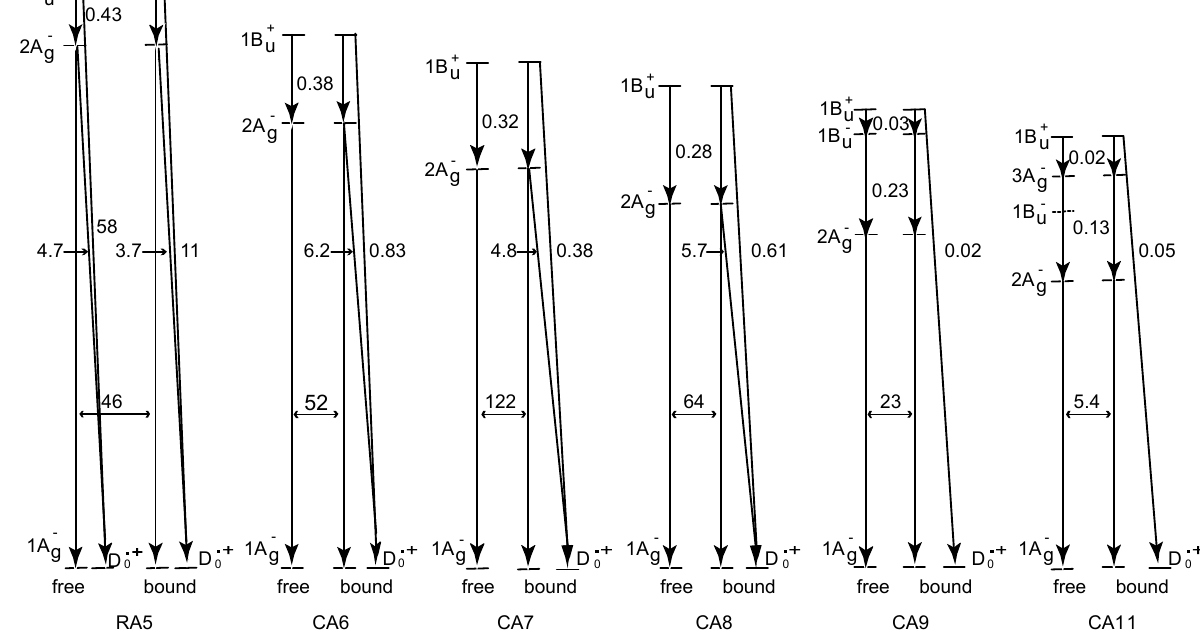
Figure 5. The pathways of internal conversion and electron injection for the RA and CA sensitizers free in solution and bound to TiO constant for each pathway is shown in picoseconds (the T D 0•+ state when bound which is not indicated) (reprinted from [4] with permission of the American Chemical